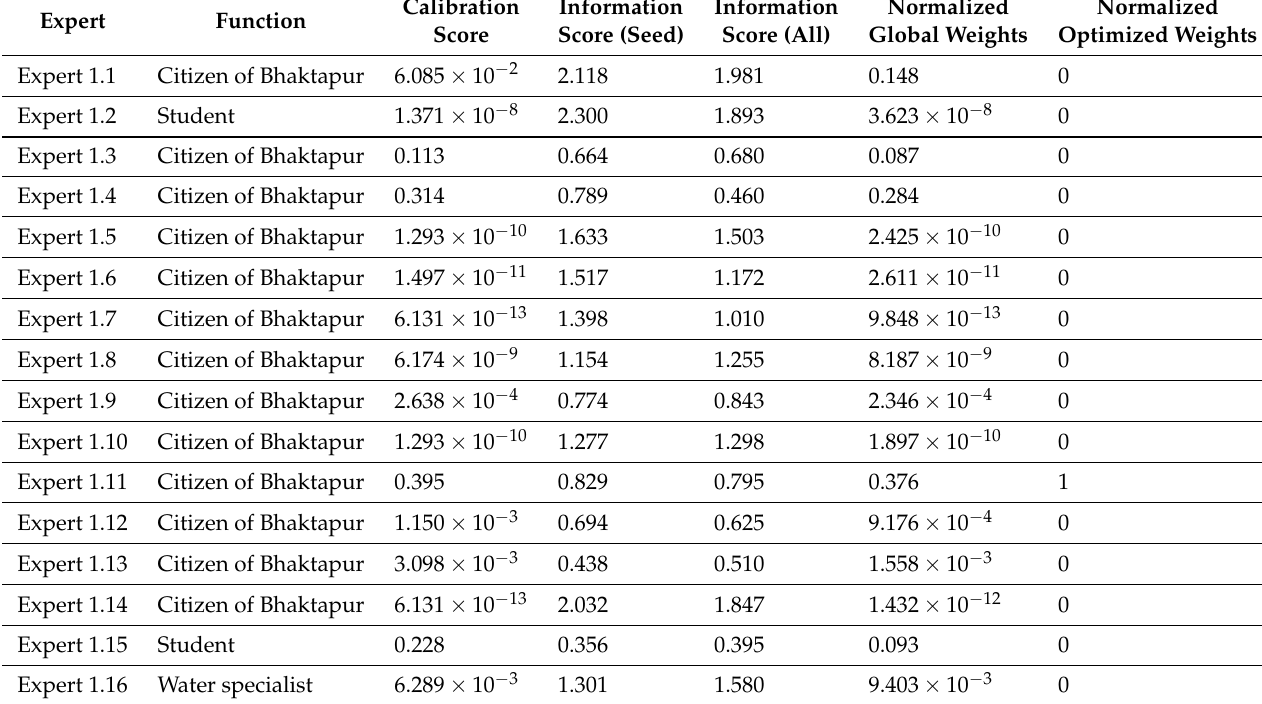
Table A2. Calibration and Information scores for experts in panel